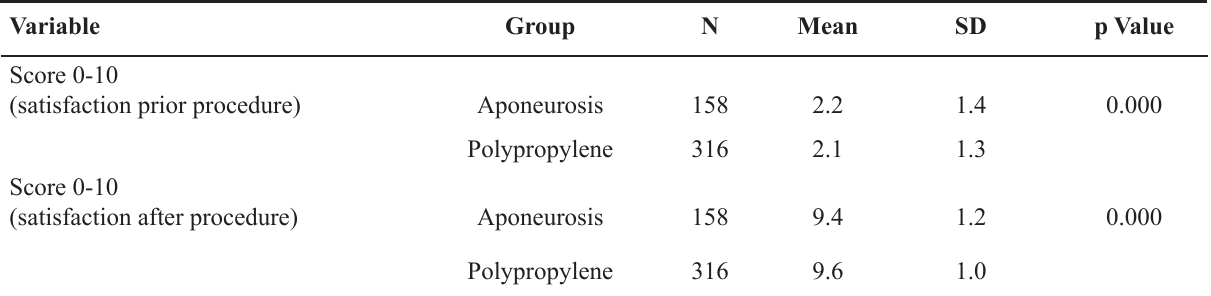
Table 3 – The mean of the scores from 0 to 10, given by the patients prior and after the procedure with aponeurosis or polypropylene